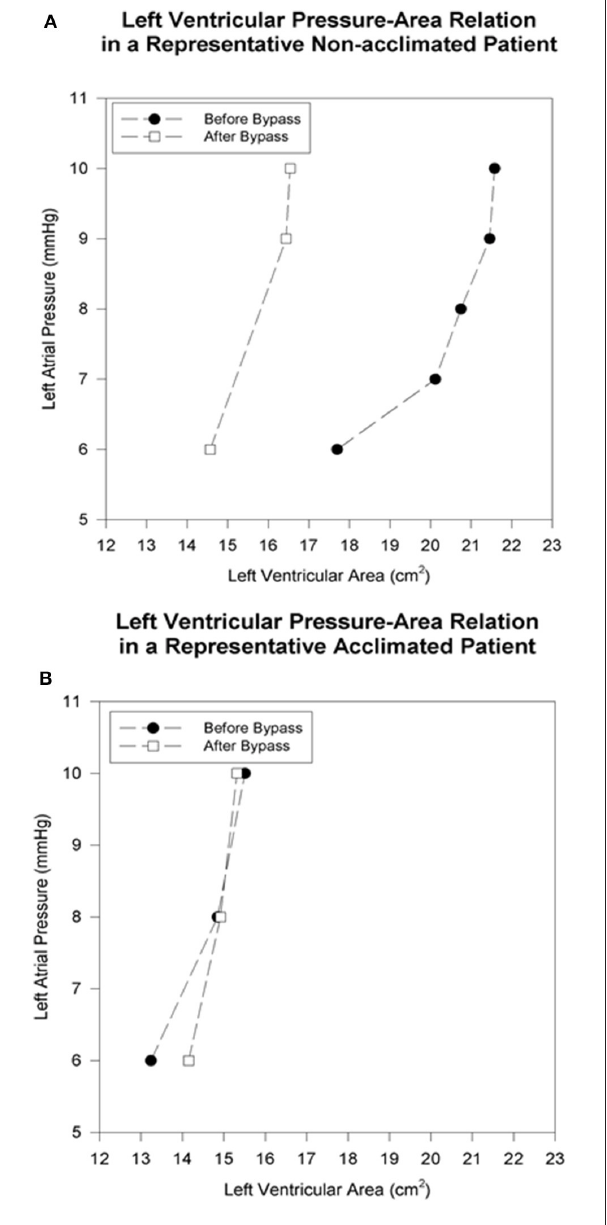
FIGURE 1 | Left ventricular pressure-area relation in representative patients before and immediately after cardiopulmonary bypass. The baseline left atrial pressure of 6 mmHg is progressively increased by volume loading. (A) In the non-acclimatized patient, the left-ventricular end-diastolic area is smaller after bypass at each pressure level, as reflected by a leftward shift of the pressure-area relation. (B) In the acclimatized patient, the pressure-area relation maintains its position after bypass, without significant change in left-ventricular end-diastolic area at comparable pre- and post-bypass